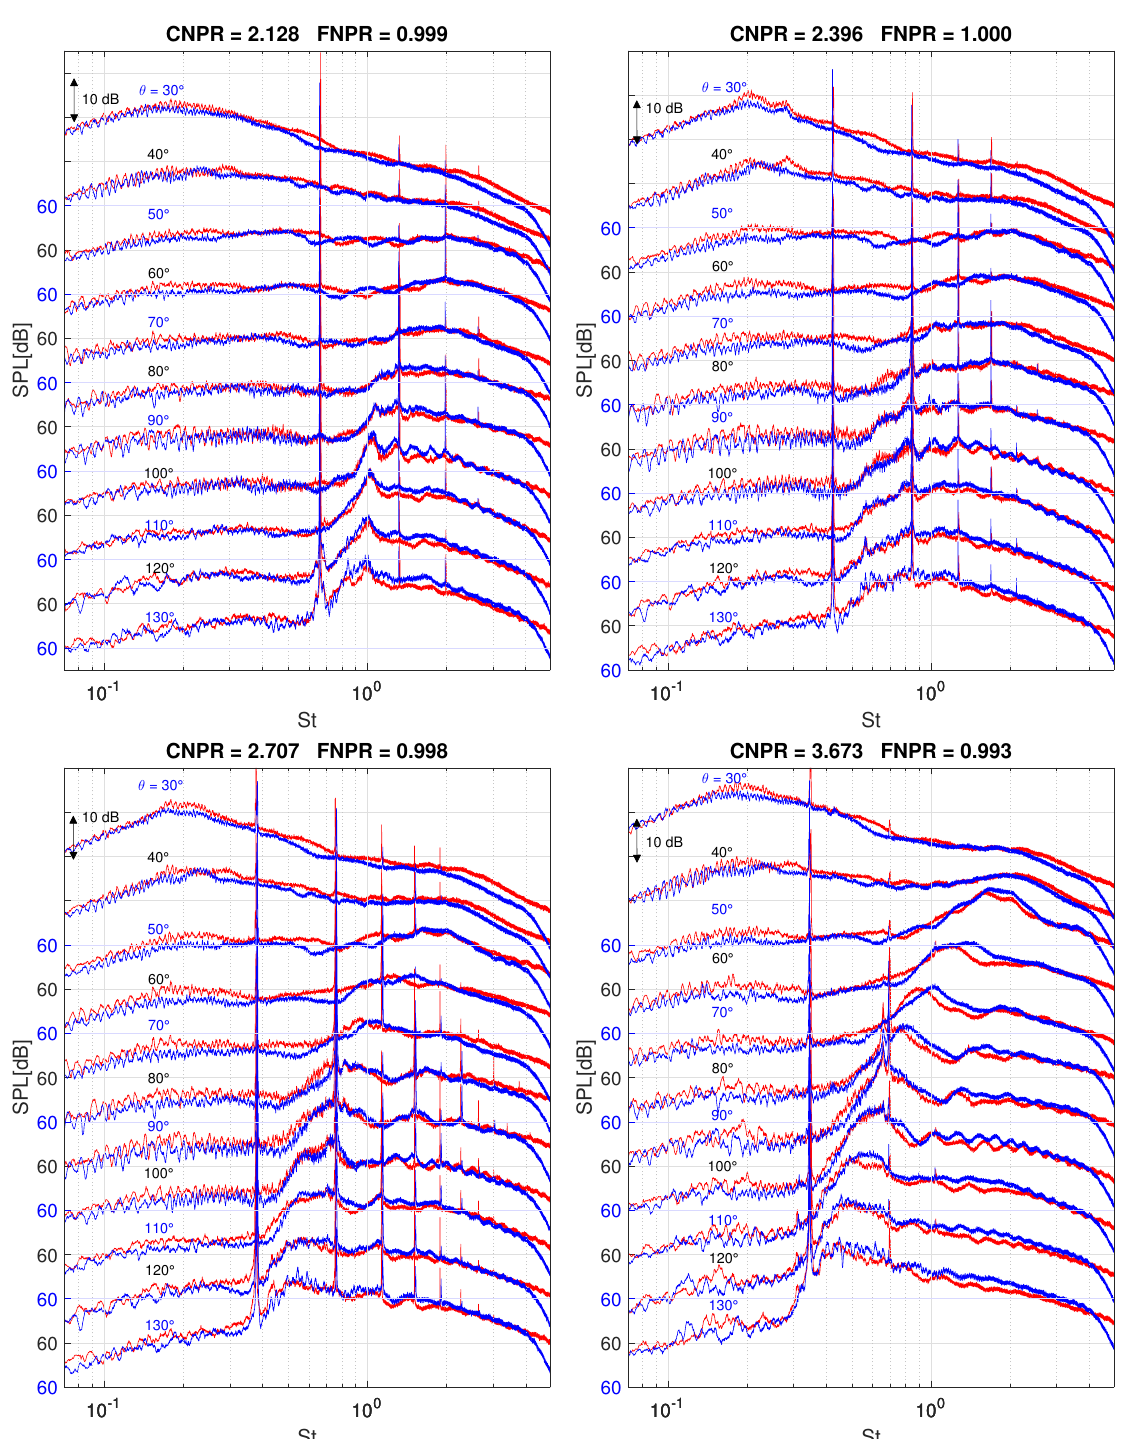
Figure 24. SPL (reference 2 × 10 − 5 Pa) at r / D 1 = 40 for several CNPRs at all the measured angles. The red and blue lines are for nozzle diameter D = 0.0240 m and D = 0.0192 m, respectively. The drop of the SPL at higher St for the smaller nozzle is due to the limit of the microphones’ dynamic range (70